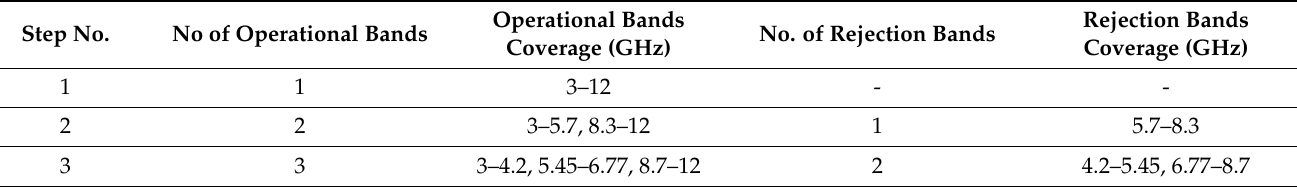
Figure 5. S-Parameter ( S 11 ) performance at each design step of proposed antenna. Table 2. Operational and Rejection band coverage at each design step.